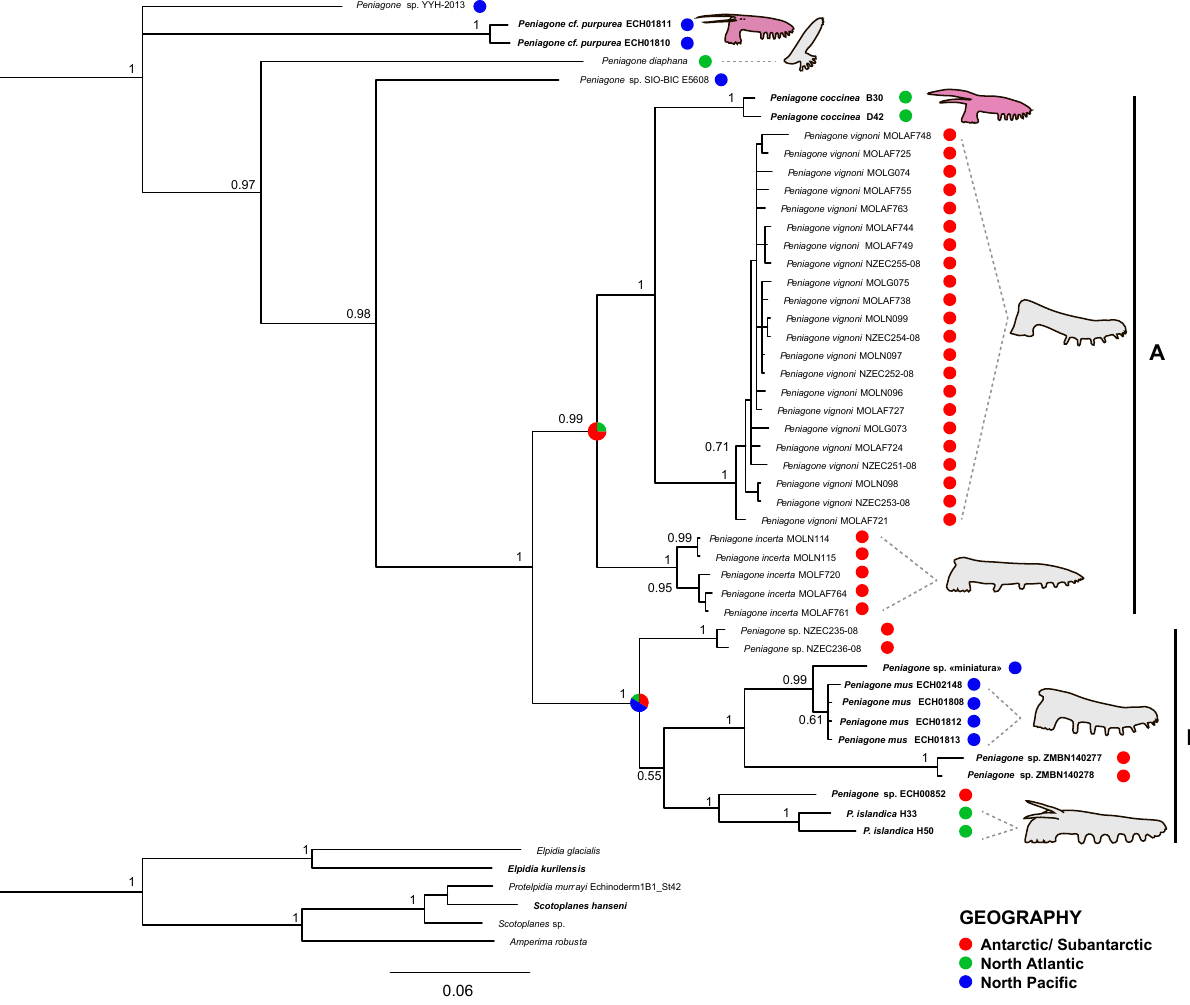
Figure 9. Bayesian phylogenetic tree inferred from mtDNA COI sequences. Sequences obtained in this study are in bold. Node numbers are posterior probabilities. NZEC2XX-08 correspond to BOLD process ID numbers. Holothurian pictograms are colored according to the color of preserved specimens.